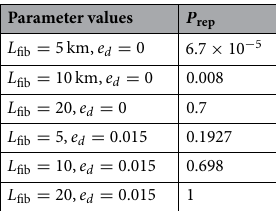
Table 4. P rep for different values of L fib and e d